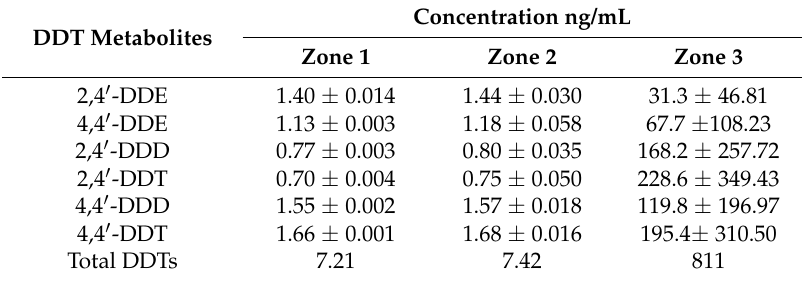
Table 2. Average concentrations ( ± standard deviation) and distribution of DDTs in the study area.